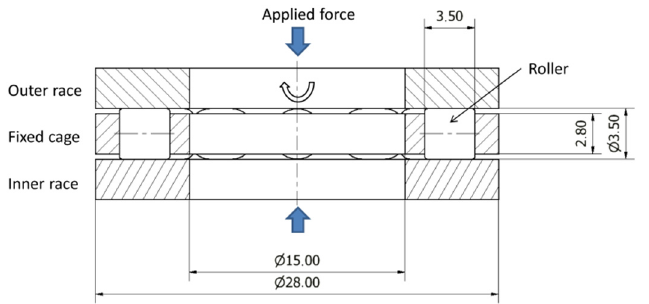
Figure 1. Geometry of K81102TN cylindrical roller thrust bearing and loading conditions applied in the analysis. Table 1. Chemical composition of bearing steel AISI 52100 (in wt%) [40].